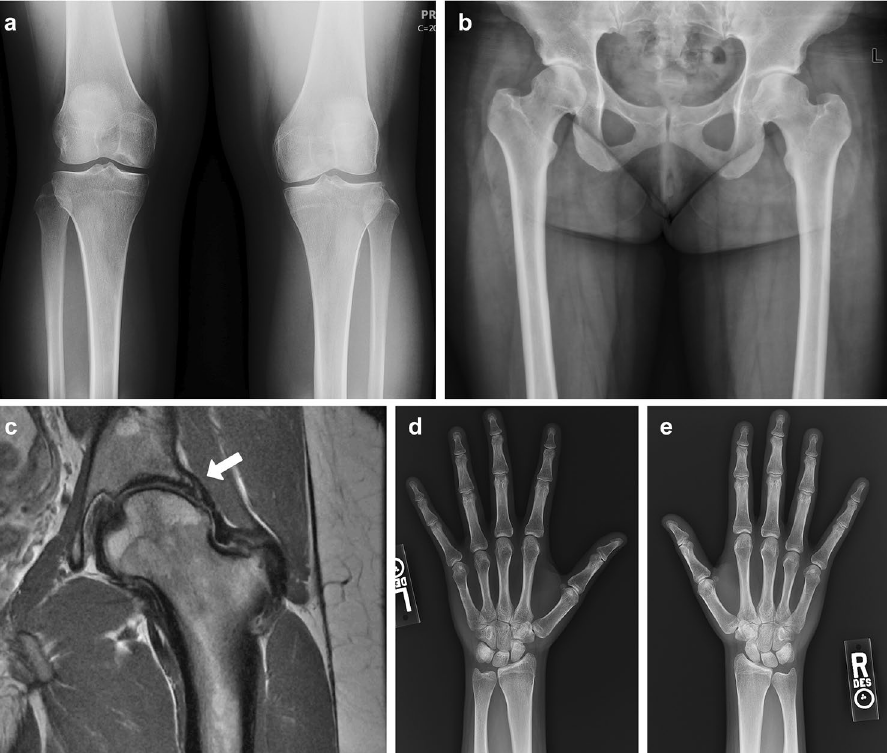
Figure 2. Clinical observations in Family 3. The proband is a now 33-year-old woman, 156 cm tall, with joint pain, early onset osteoarthritis and osteochondral lesions in multiple joints, including knees ( a ) and hips ( b ). She has had hip arthroscopic treatment for femoral-acetabular impingements and labrum tears ( c , arrow). Hand X-rays show short and broad distal phalanges of the thumbs ( d , e ). She has a family history of short stature and joint problems on the paternal side, including OCD.